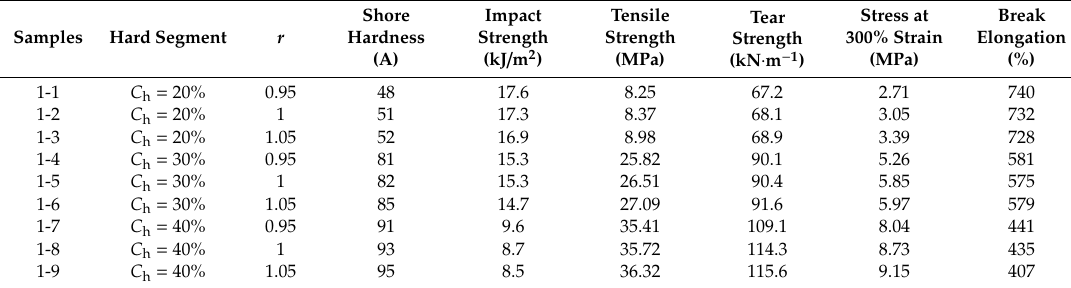
Table 11. Physical and mechanical properties of polyester-based TPUs.